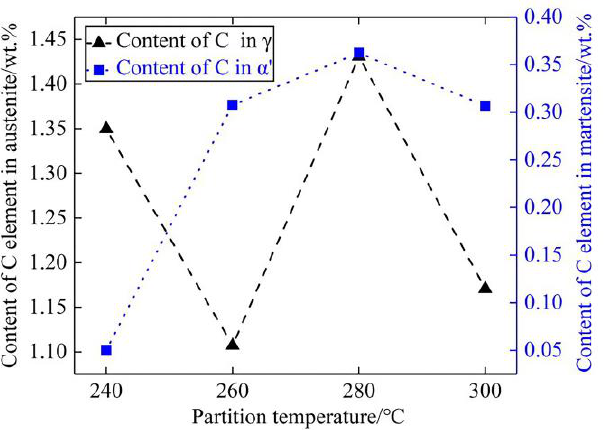
Figure 5. Average carbon contents in retained austenite and martensite for the samples treated at different partitioning temperatures.